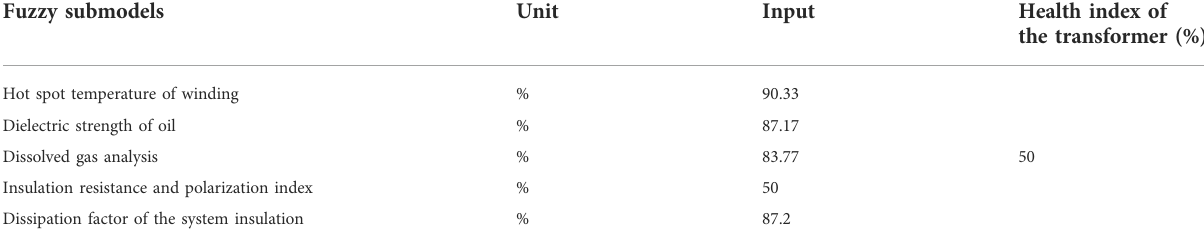
TABLE 8 Health index based on fuzzy submodels.